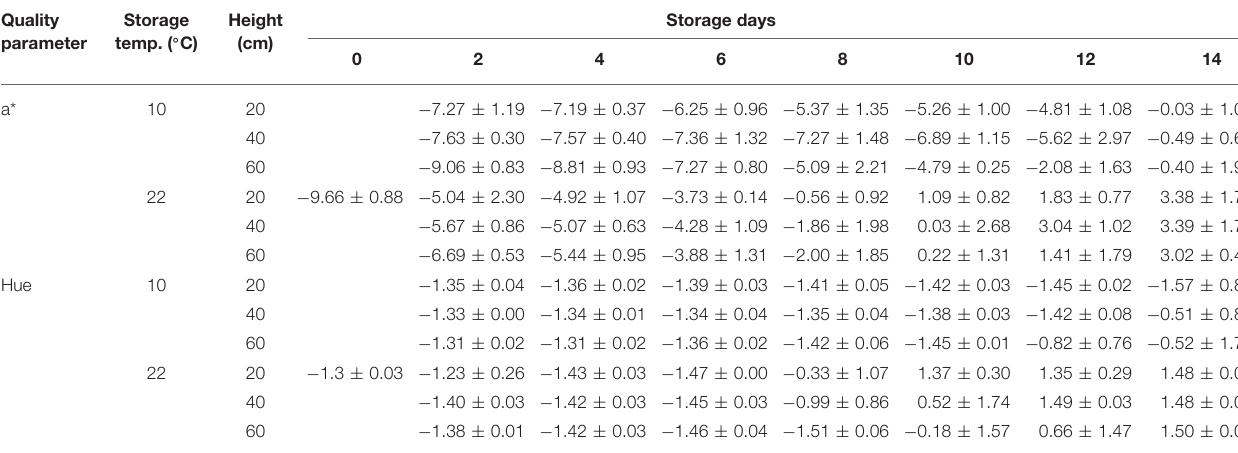
TABLE 3 | a * and hue values of pears impacted with three drop heights levels at two storage conditions during 14 days of storage. Quality Storage Height parameter temp. ( ◦ C)